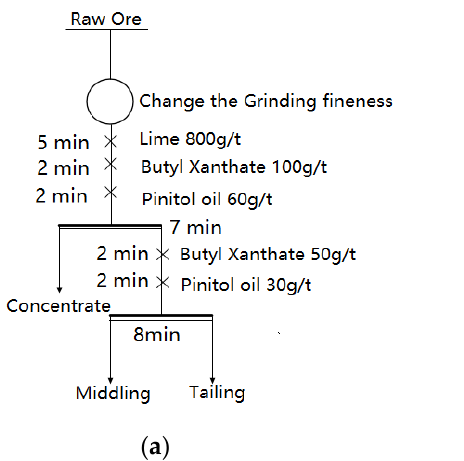
Figure 6. Effect of grinding size on the recovery of sulfide aggregates. ( a ) The flow chart for flotation experiments ( b ) Effect of grinding size.